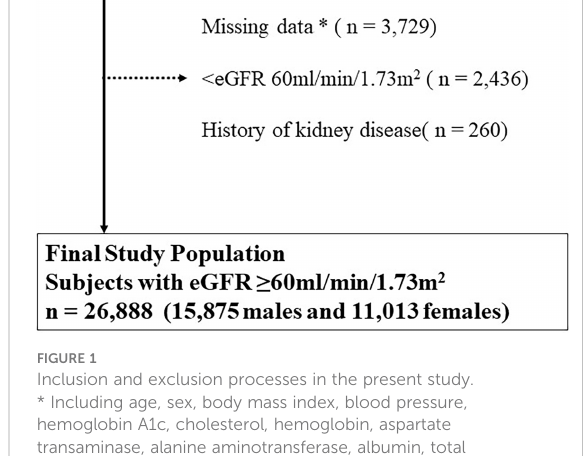
FIGURE 1 Inclusion and exclusion processes in the present study. * Including age, sex, body mass index, blood pressure, hemoglobin A1c, cholesterol, hemoglobin, aspartate transaminase, alanine aminotransferase, albumin, total cholesterol, triglyceride, high-density lipoprotein cholesterol, low-density lipoprotein cholesterol, fasting blood sugar level, insulin, uric acid, serum creatinine, eGFR, smoking status, drinking frequency, sleeping duration, exercise frequency, presence or absence of snacking and late-night dinner, and current treatments for diabetes, dyslipidemia, hypertension, hyperuricemia, stroke, and coronary disease. eGFR, estimated glomerular fi ltration